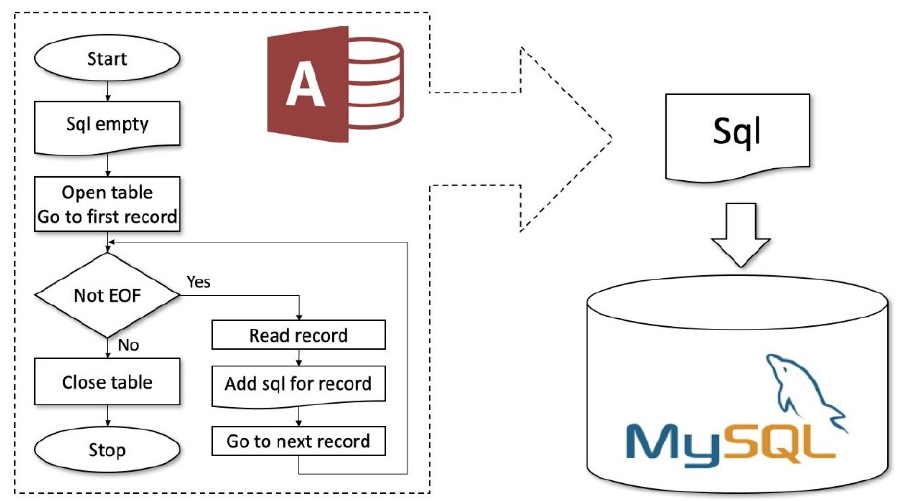
Figure 2. Flow diagram of data exportation from Microsoft Access to MySQL.